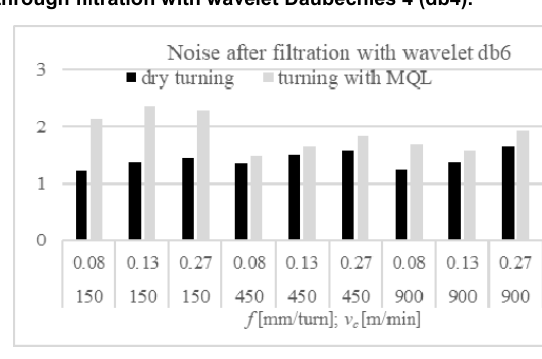
Figure 12. Noise and disturbance values in composite turning with uncoated carbide insert (H10), obtained through filtration with wavelet Daubechies 4 (db4).